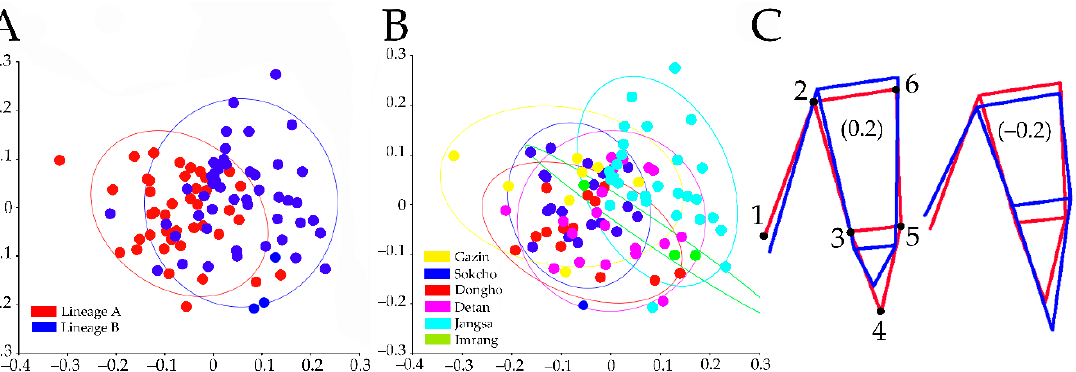
Figure 4. Principal component analysis on the residuals of sensilla distribution (SD) and pleonal points (PP) shape coor- dinates and wire frame images. ( A ) Scatter plot classified by lineage on the female SD dataset, both axes indicate principal component I and II, respectively; ( B ) scatter plot classified by population on the female SD dataset; ( C ) SD shape change (blue line) against mean shape (red line) according to the corresponded shape scores, the digitized landmarks are indicated by the numbers; ( D ) scatter plot classified by lineage on the female PP; ( E ) scatter plot classified by population on the female PP; ( F ) PP shape change (blue line) against mean shape (red line) according to the corresponding shape scores.